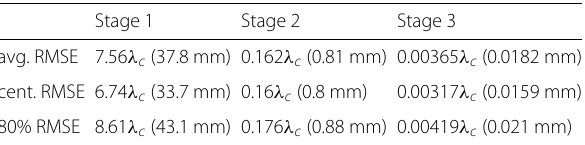
Table 1 RMSEs for search/scan stages ( G 2 and N =